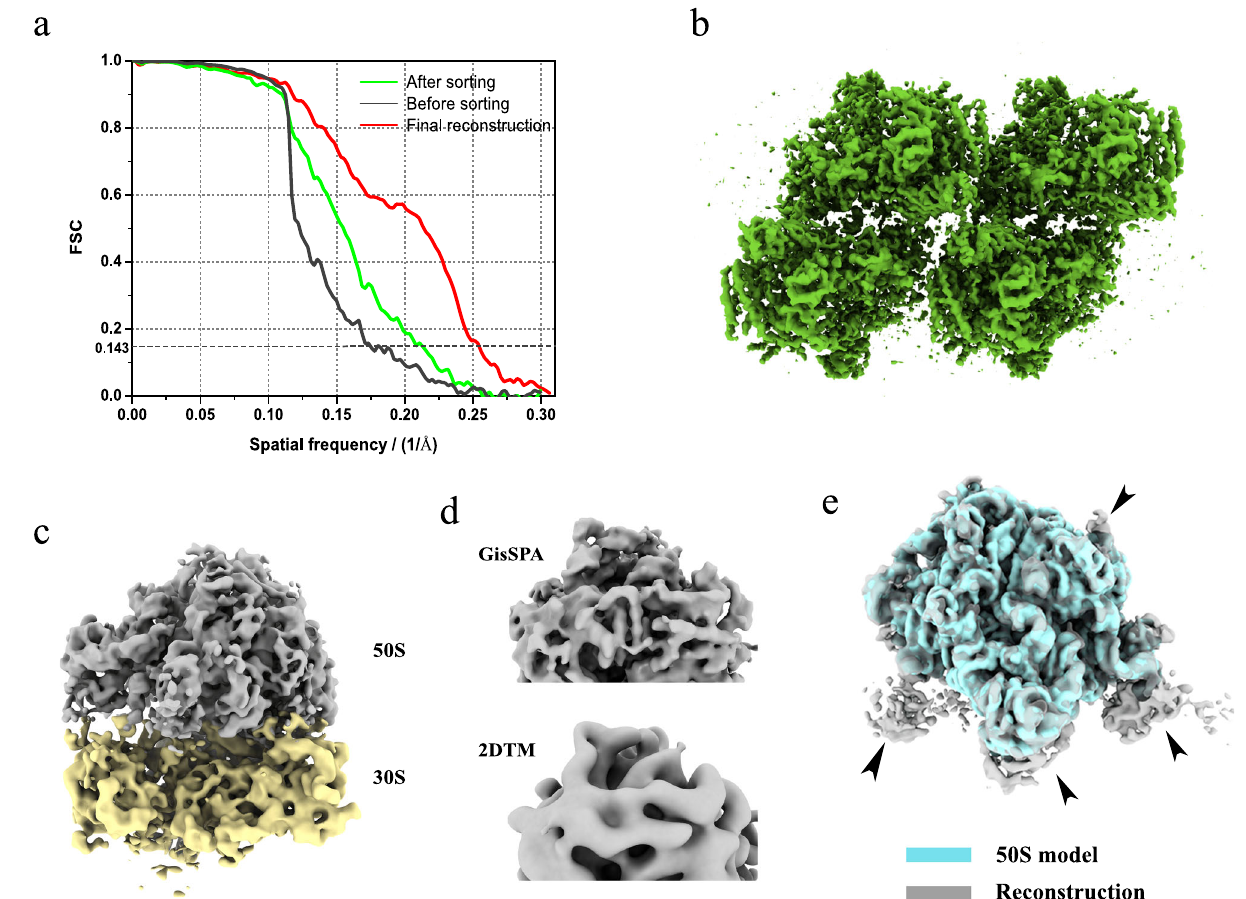
Fig. 4 | PSII tetramer of P. purpureum lamella and ribosome of M. pneumoniae resolvedbyGisSPA.a FSCcurvesofPSIItetramerreconstructionbefore(dark)and after (green) removing false positives by sorting method. The fi nal resolution reached 3.9Å after adding more micrographs (red). b Reconstruction of PSII tet- ramerat3.9Å. c 3DreconstructionresolvedbyGisSPAwitha M.pneumoniae 50Sas